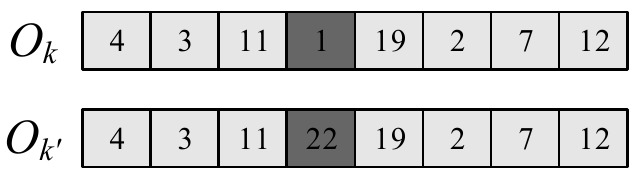
Figure 6. Single-point crossover operation.